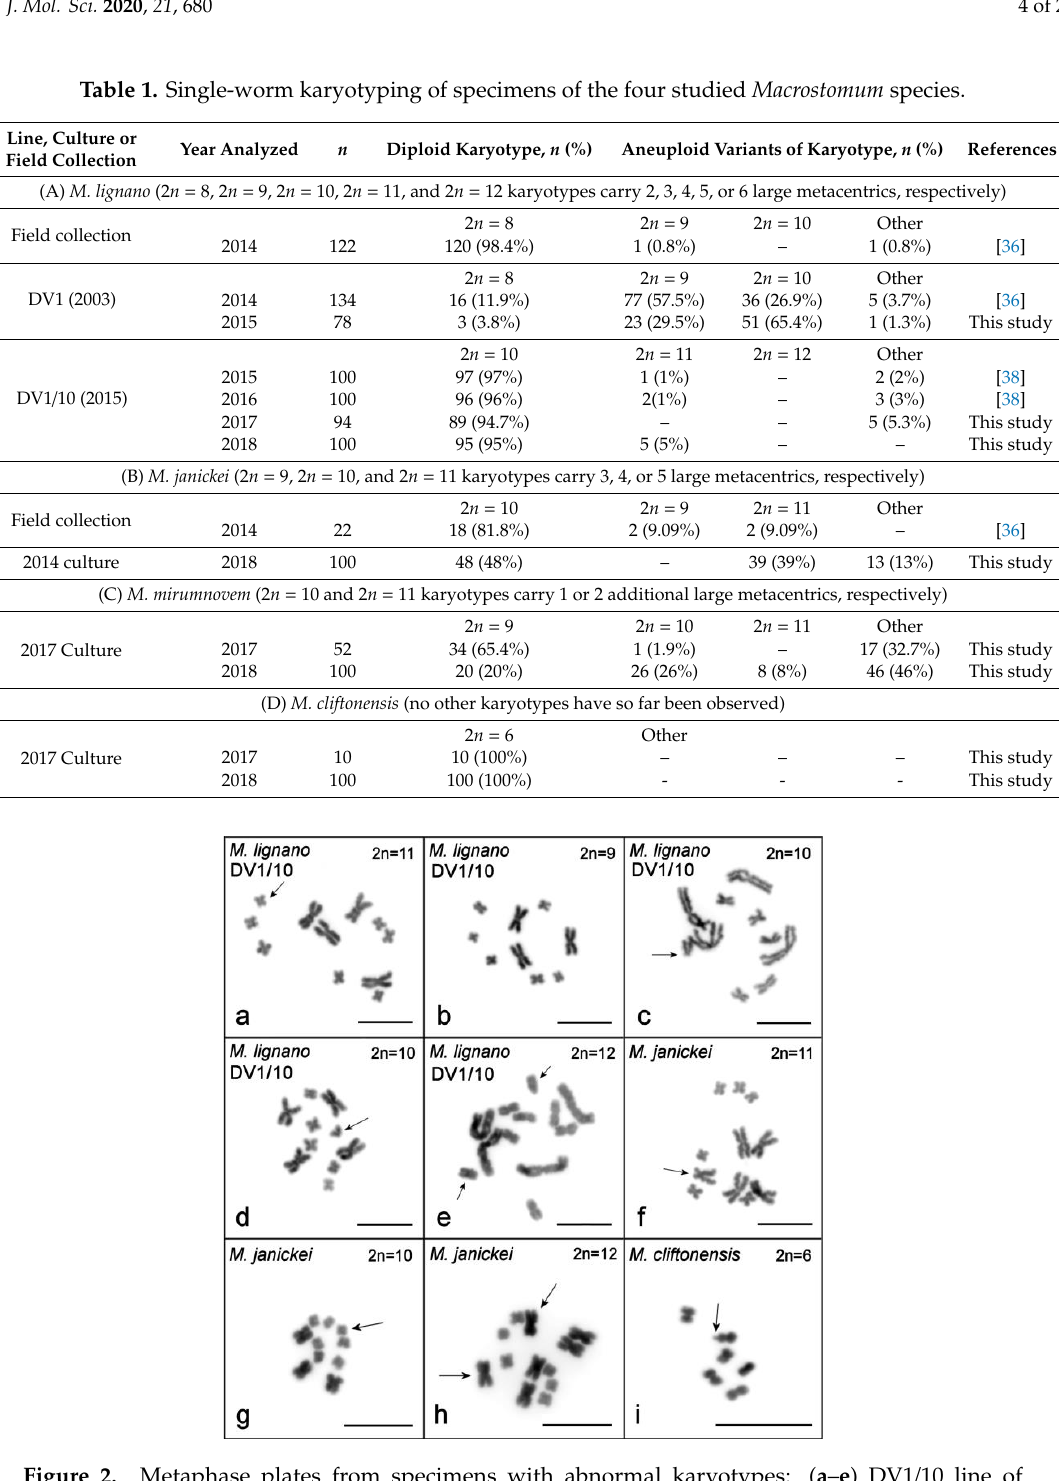
submetacentric chromosome; ( g ) one small extra chromosome; ( h ) two additional large metacentric chromosomes; ( i ) metaphase plate of M. cliftonensis with chromosome showing secondary constriction in one homolog of MCL1. Chromosomal abnormalities and secondary constriction are marked with arrows. Scale bar 10 µ